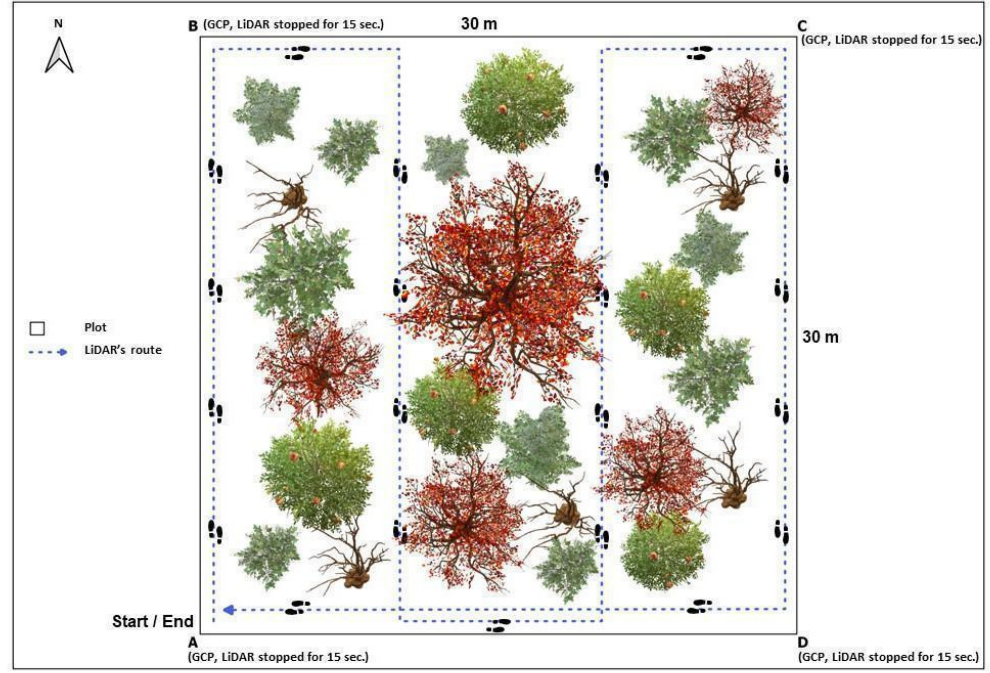
Figure 3. Walking with LiDAR PLS inside the plot.